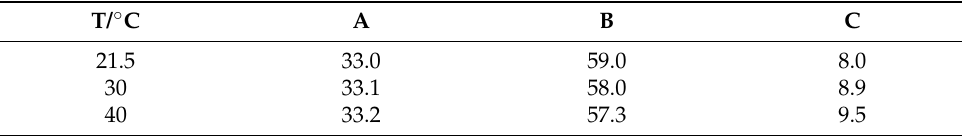
Table 2. Content of rotamers (%) of racemic 1 at different